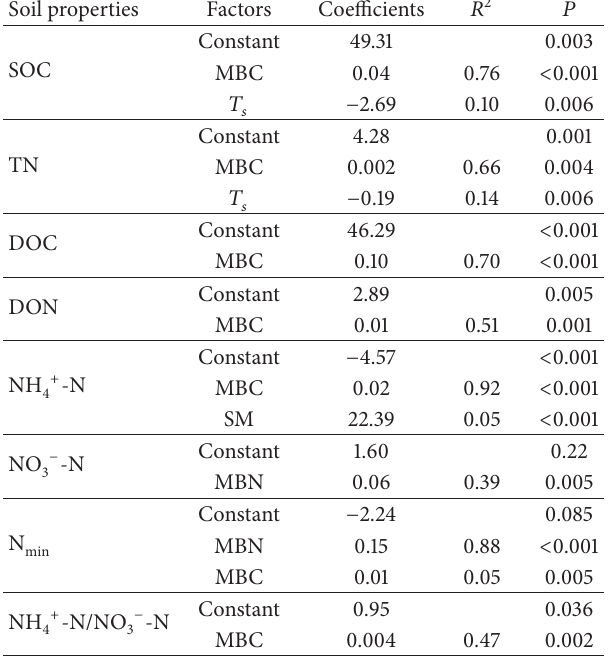
Table 3: Multiple stepwise regression analyses between soil proper- ties and environmental variables (soil temperature, 𝑇 𝑠 ; soil moisture, SM) and soil microbial biomass (microbial biomass C, MBC; microbial biomass N, MBN) in an alpine meadow on the Tibetan Plateau. MBC and MBN data were obtained from Fu et al.